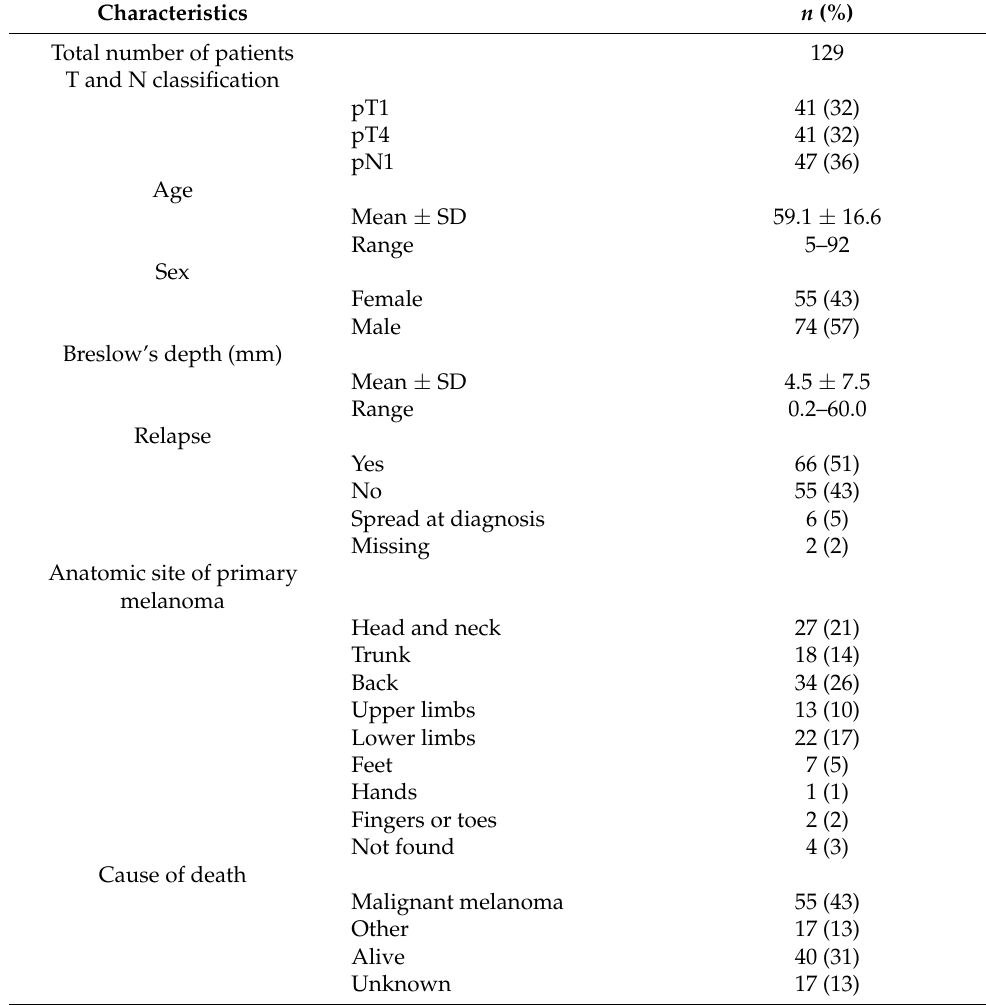
Table 3. Clinicopathological characteristics of malignant cases. pT = pathological tumor stage, pN = pathological nodal stage, SD = standard